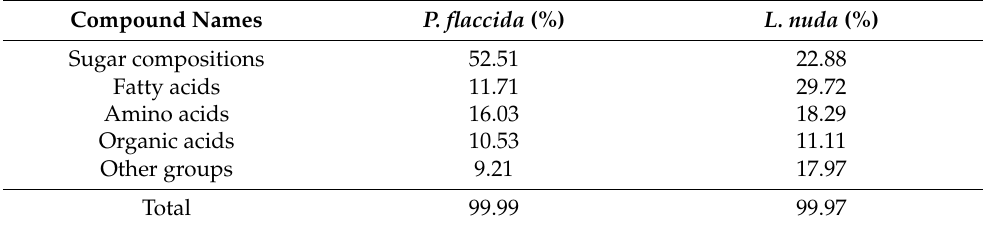
Figure 2. GC – MS chromatogram of L. nuda derivatized methanolic extract. Table 3. Biomolecule groups of the derivatized methanolic extracts by GC – MS analysis.